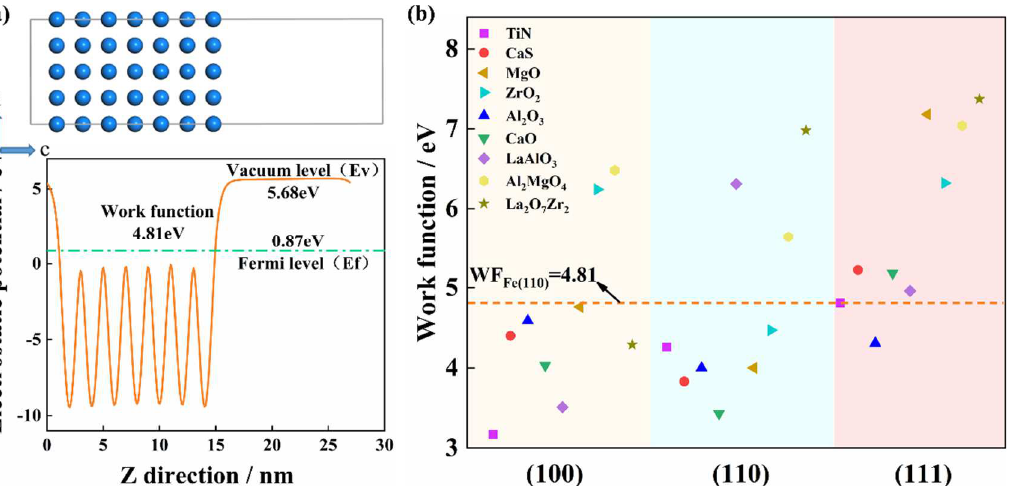
Figure 11. Calculated work function of the inclusions and Fe matrix. ( a ) Electrostatic potential curve of Fe (110) slab model, ( b ) work function of the different crystal planes (low index) of the inclusions.